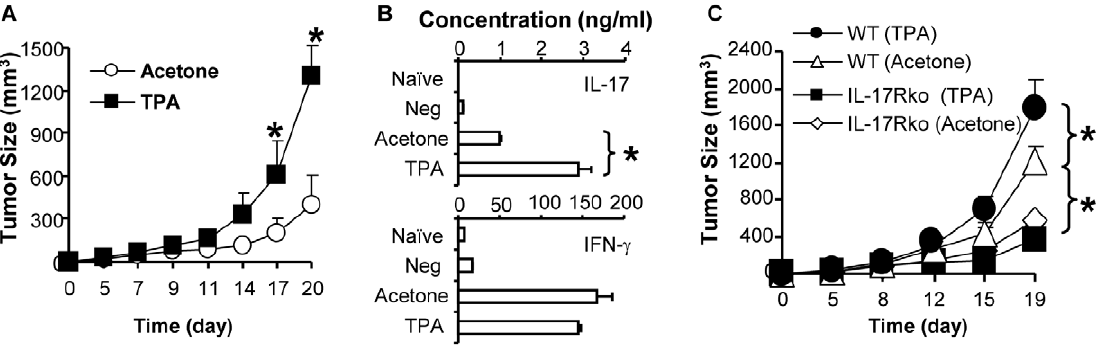
Figure 4. TPA induced promotion of tumor growth is abrogated in IL-17R-/- mice. A). TPA induced inflammation enhances tumor growth. Wild type C57Bl/6 mice were treated epicutaneously with TPA or acetone (vehicle controls) every other day for a total of 5 applications. The mice were then inoculated subcutaneously with EG7 tumor cells. Tumor growth was monitored (n=5). B). TPA induced inflammation increases tumor specific IL-17 producing cells. At the end of experiments, the draining lymph node lymphocytes were collected from EG7 tumor bearing mice that were treated with TPA or acetone. The cells stimulated with OVA pulsed BM-DC for 4 days. Concentrations of cytokines in supernatants were measured by ELISA (n=4). Naı¨ve T cells with OVA pulsed BM-DC (Naı¨ve) and immune T cells with BM-DC without OVA (Neg) served as controls in the cultures. C). TPA induced tumor promotion is abrogated in IL-17R-/- mice. Wild type or IL-17R-/- were epicutaneously treated with TPA or acetone every other day for a total of 5 applications. The mice were then inoculated with EG7 tumor cells and tumor growth was monitored (n=5). Data are representative of 2–3 independent experiments (mean + / 2 SEM, * P , 0.05).